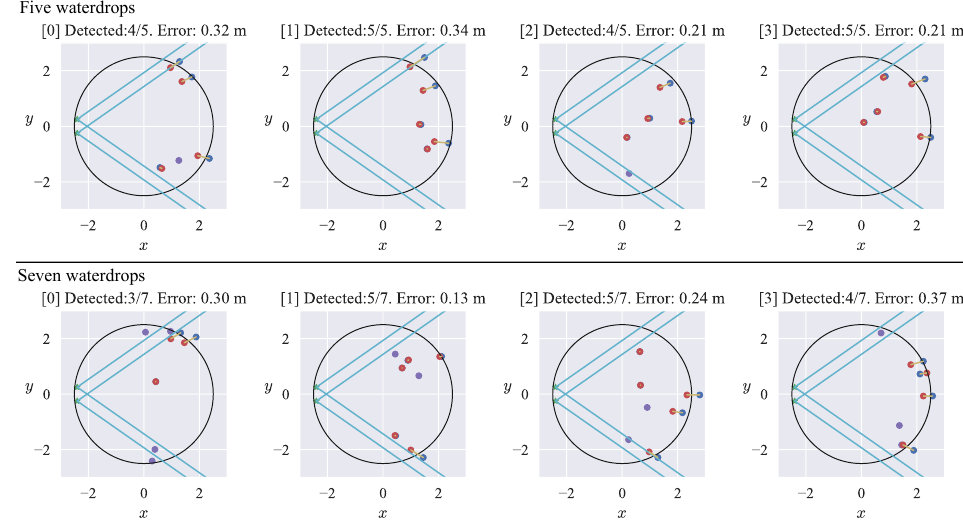
Figure 8. Ground truth and estimated leakage positions. The first row and second row are the results with five and seven leakage positions, respectively. The number of detections and mean error of the estimated leakage positions are indicated above each figure. The red and blue dots indicate the ground truth and estimated leakage positions, respectively. The yellow lines illustrate the correspondence of the ground truth with the estimated leakage positions. The leakage positions that were not detected are represented as the purple dots. For reference, the camera positions and the fields of the view are illustrated as the greed dots and the cyan lines,